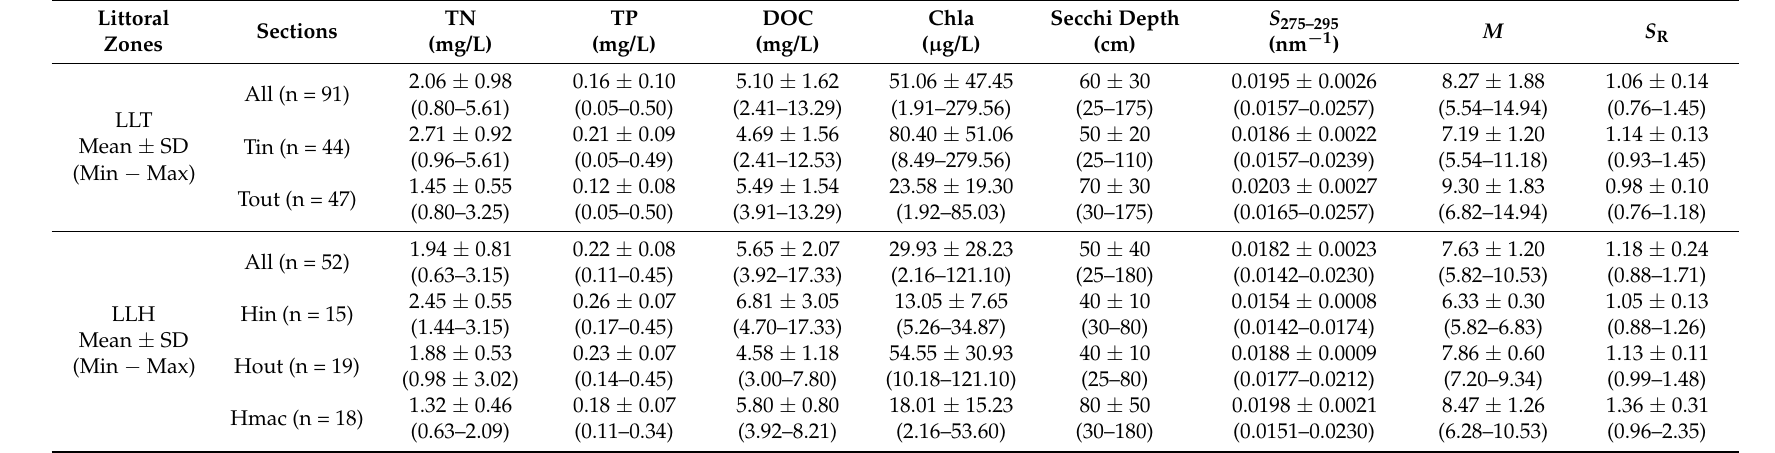
Table 1. Measured nutrient, biological, and optical parameters of water samples summarized as descriptive statistics in the littoral zones of Lakes Taihu and Hongze: All, all sampling sites in LLT or LLH; Tin or Hin, sampling sites of the upstream in LLT or LLH; Tout or Hout sampling sites of the downstream in LLT or LLH; Hmac, sampling sites of zones where aquatic macrophyte dominated and being less affected by rivers in